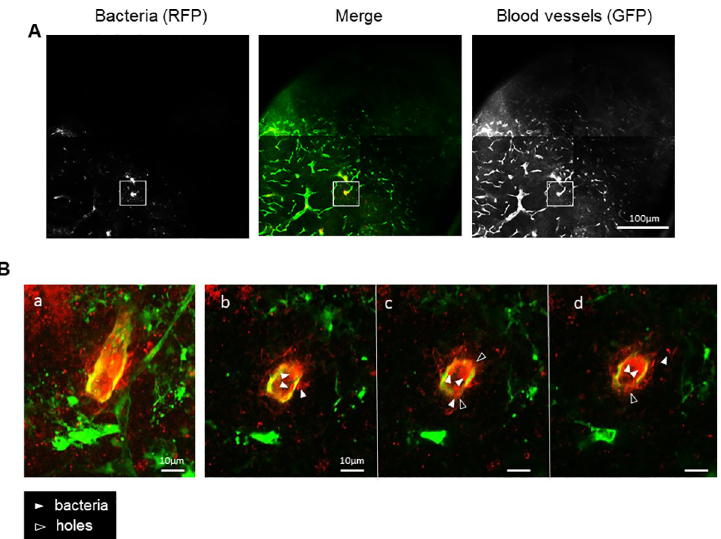
Fig 3. Confocal microscopy, observation of the blood vessels and bacteria in the non-draining lymph node of a Y . pestis -infected Flk1-GFP mouse. A. Bacteria (left panel) and blood vessels (right panel) are merged in the middle panel. Bar = 100 μ m. Image are reconstructed from 4 panels (2x2), each panel corresponding to the maximum of intensity (MIP) calculated on a 200 μ m section of the bubo (20 sections separated by 10um). Frame correspond to panel B and S4 Video. B. Magnifications of a blood vessel filled with bacteria. The panel a. represent the MIP calculated on a 50 μ m thick section (100 sections separated by 0.5um); panels b-c-d are successive sections of panel a. White plain arrowheads point at red bacteria within and outside the vessel, white empty arrowheads point at some holes in the vessel. Bar = 10 μ m.